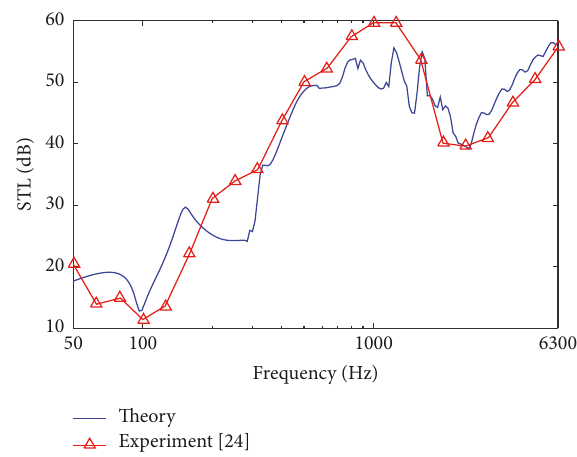
Figure 10: Comparison of the theoretical prediction values and experimental results for the typical sandwich structure with unidi- rectionally parallel